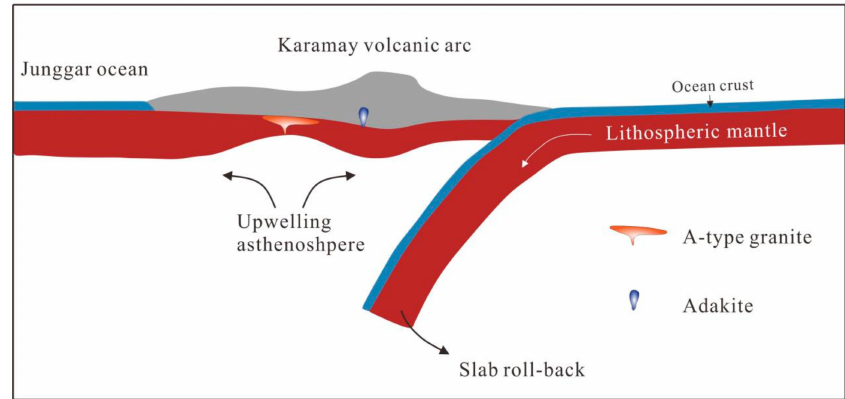
Figure 15. Tectonic model for slab roll-back to explain the generation of studied granitoids from Western